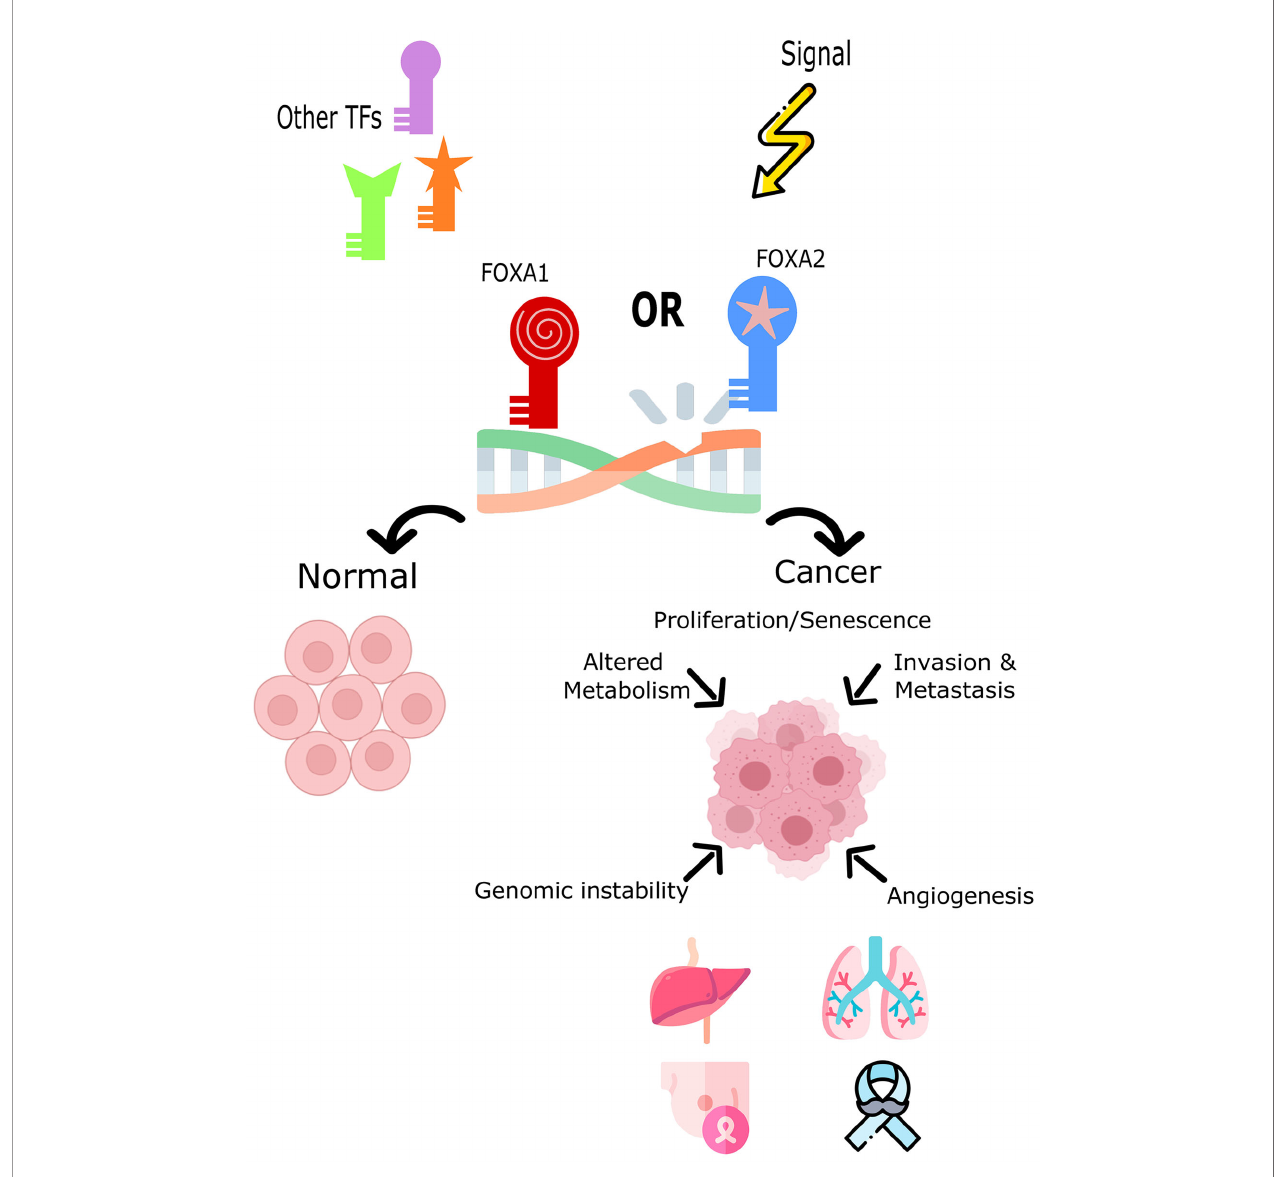
FIGURE 1 | The role of FoxA1 and FoxA2 in cell fate decision or tumor induction. Both TFs impact the cell ’ s development toward normal cycle and differentiation or toward cancer and tumorigenesis. FOXA1 and FOXA2 overexpression, mutation, or down-regulation is associated with different cancers such as, lung, liver, breast, and prostate